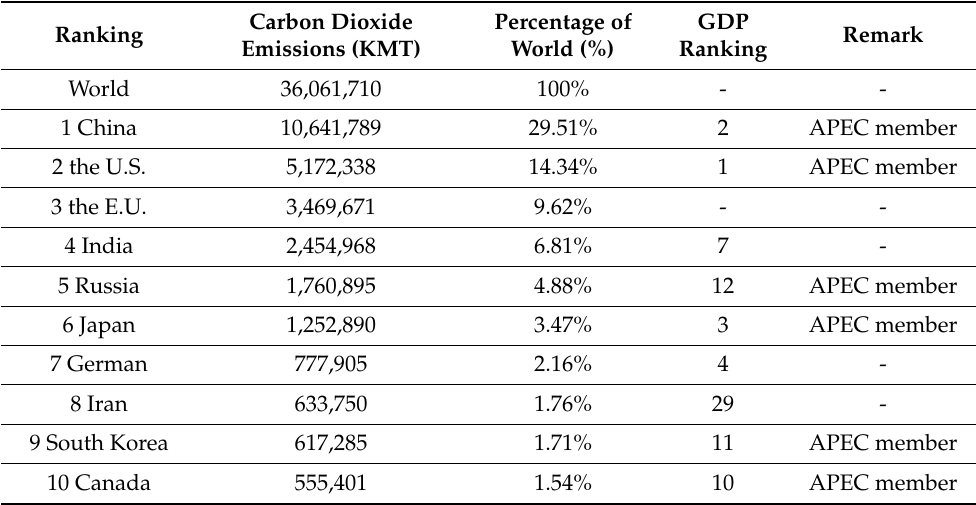
Table 1. The 10 economies with the top carbon dioxide emissions worldwide in